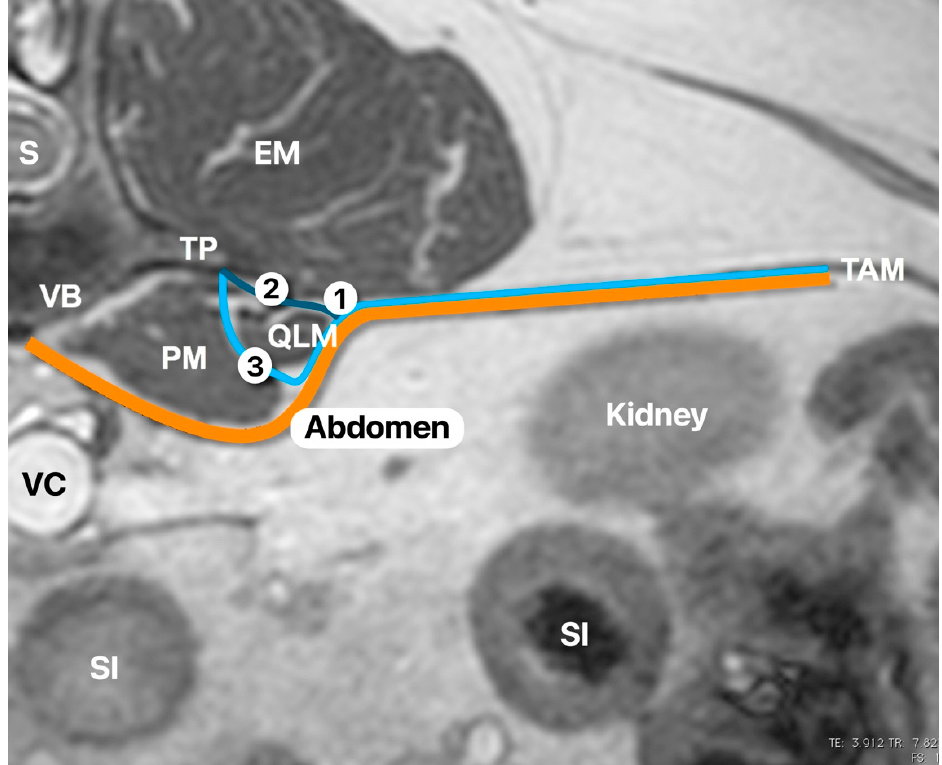
Figure 1. Transverse view of a canine abdominal MRI at the level of the first lumbar vertebrae (L1) to illustrate the anatomy. The picture shows the relevant anatomy related to the quadratus lumborum block (QLB) and the different approaches described in the human literature to perform the QLB. PM, psoas muscle; QLM, quadratus lumborum muscle; TP, transverse process; VB, vertebral body; S, spine; EM, epaxial muscles; TAM, transversus abdominis muscle; VC, vena cava; SI, small intestine. The orange line is the fascia transversalis. The light blue line is the anterior thoracolumbar fascia. The dark blue line is the middle thoracolumbar fascia (based on three-layered model of the thoracolumbar fascia [7]). (1) Point of injection of the QLB1 technique; (2) point of injection of the QLB2 technique; (3) point of injection of the QL3 technique. Picture was taken and modified by the author without any copyright dispute